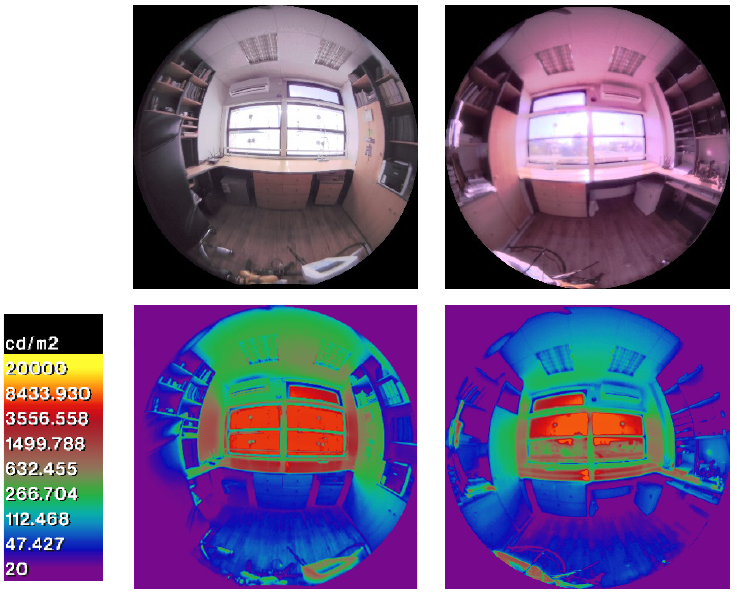
Figure 13. Luminance map of 7 March 2020, at 9:30 a.m. in local time (UTC-3).